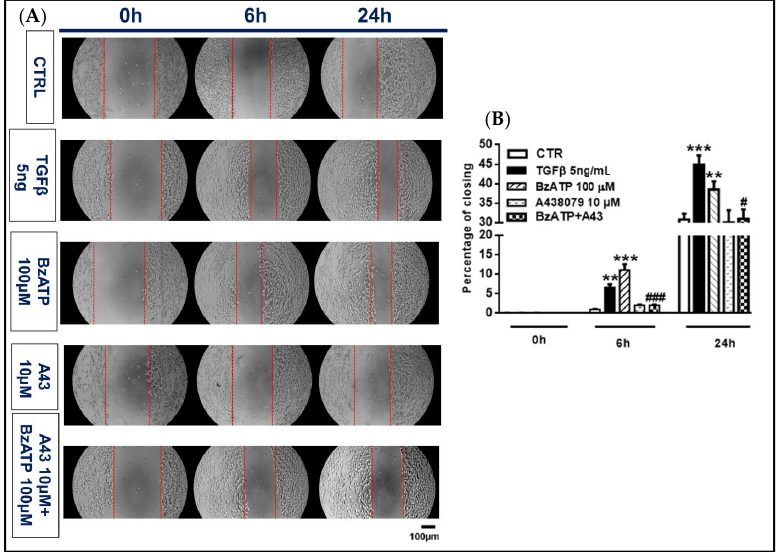
Figure 7. Effect of TGF β 1 and BzATP on GSC migration evaluated by scratch assay. Nearly confluent GSCs (80%) were incubated in the presence or absence of TGF β 1 or BzATP and when present, the P2X7R antagonist A438079 (A43), was added 1 h prior to the agonist. Cell were then scratch wounded and imaged at indicated times after injury. ( A ) Images of control and treated cells (GSCs #1) prior to (0 h) and 6 and 24 h after injury are representative of four independent experiments (scale bar = 100 µ m for all panels) carried out for each cell type, giving similar results. ( B ) Quantification of the wound size was performed using ImageJ and graphed as percentage of wound closure. The values in the histograms are given as means ± SEM and analyzed by one-way ANOVA and Dunnett’s post hoc test ** p < 0.01; *** p < 0.001 vs. control (CTR); # p < 0.05, ### p < 0.001 vs. BzATP. Similar data were obtained using GSCs #2 and